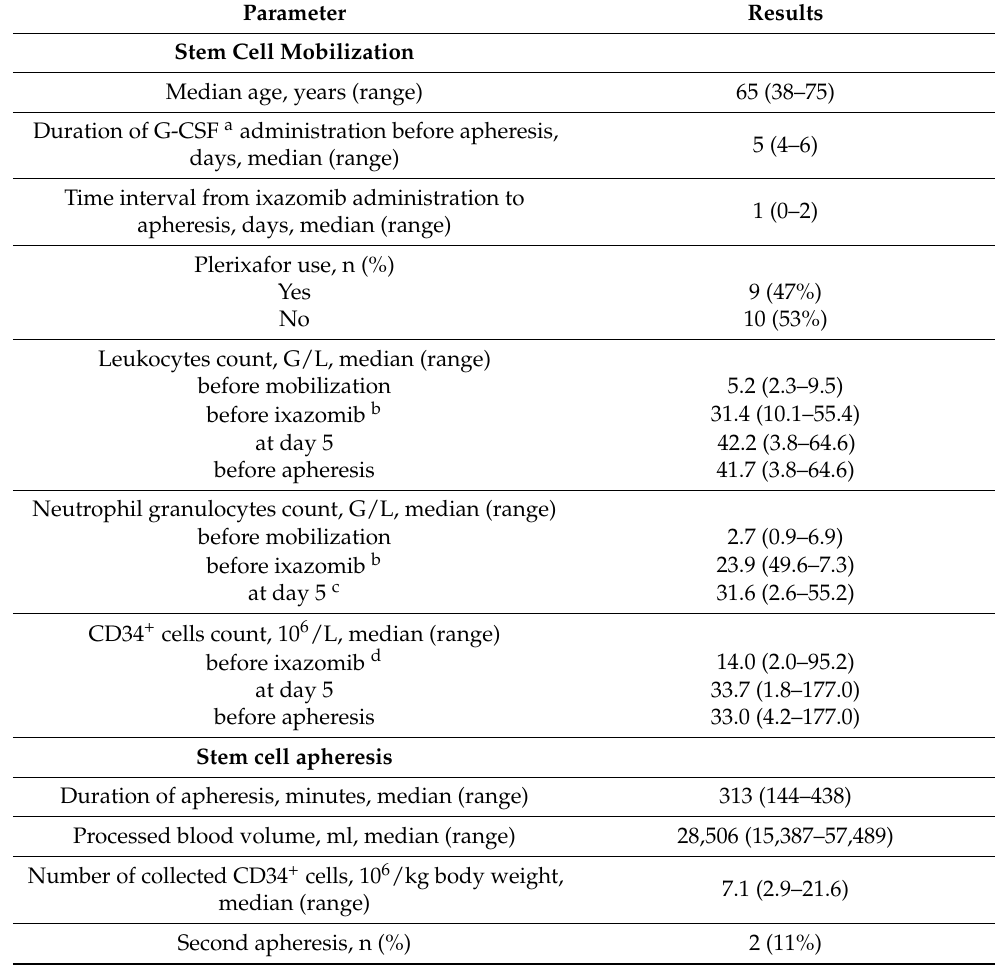
Table 3. Characteristics and results of stem cell mobilization and